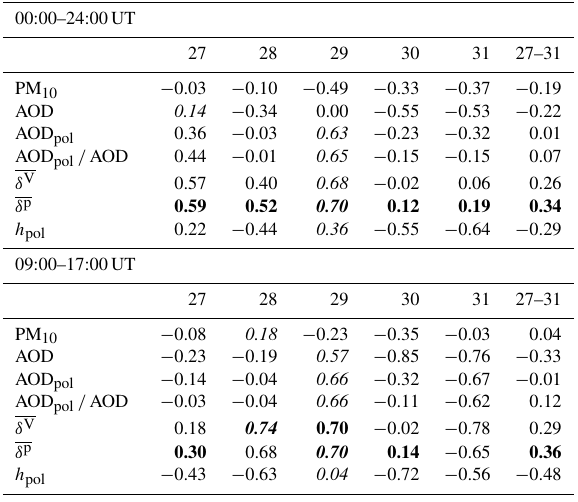
Table 3. Idem as Table 2 for Platanus